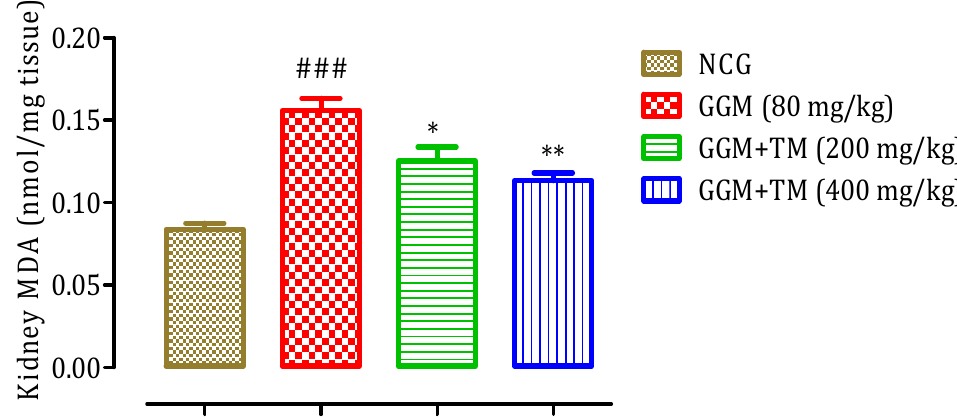
Figure 7. Effect of aqueous APTM extract on kidney MDA concentrations in GM-poisoned rats. The results are posted as mean ± SEM, (n = 6). ### p < 0.001 related to NCG. * p < 0.05, ** p < 0.01 compared to GGM (80 mg/kg).